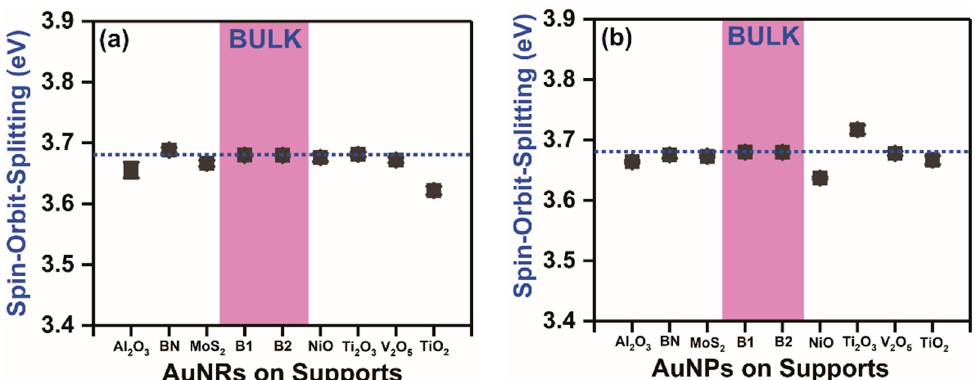
Figure 6. Spin-orbit-splitting values calculated for gold nanorods (AuNRs) on different supports ( a ) and gold nanoparticles (AuNPs) on different supports ( b ). The spin-orbit-splitting values in both supported gold nanoparticles and gold nanorods are compared against bulk gold (B1 and B2) values in all cases. Unlike the Au 4f 7/2 -to-Au 4f 5/2 peak intensity and linewidth ratios, the spin-orbit-splitting values in all supported AuNRs and AuNPs remained closer to atomic or bulk standard values.